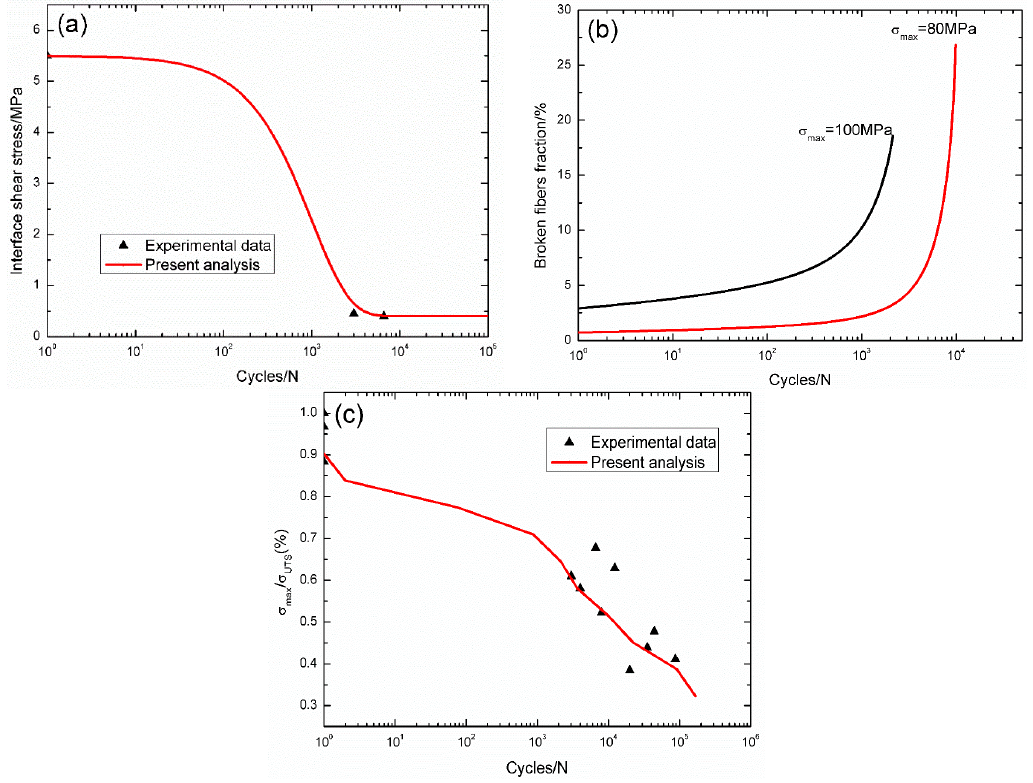
Figure 10. ( a ) The interface shear stress versus applied cycles; ( b ) the broken fiber fraction versus applied cycles; and ( c ) the fatigue life S–N curves of experimental data and theoretical analysis for cross-ply C/SiC composite at 800 °C in air.